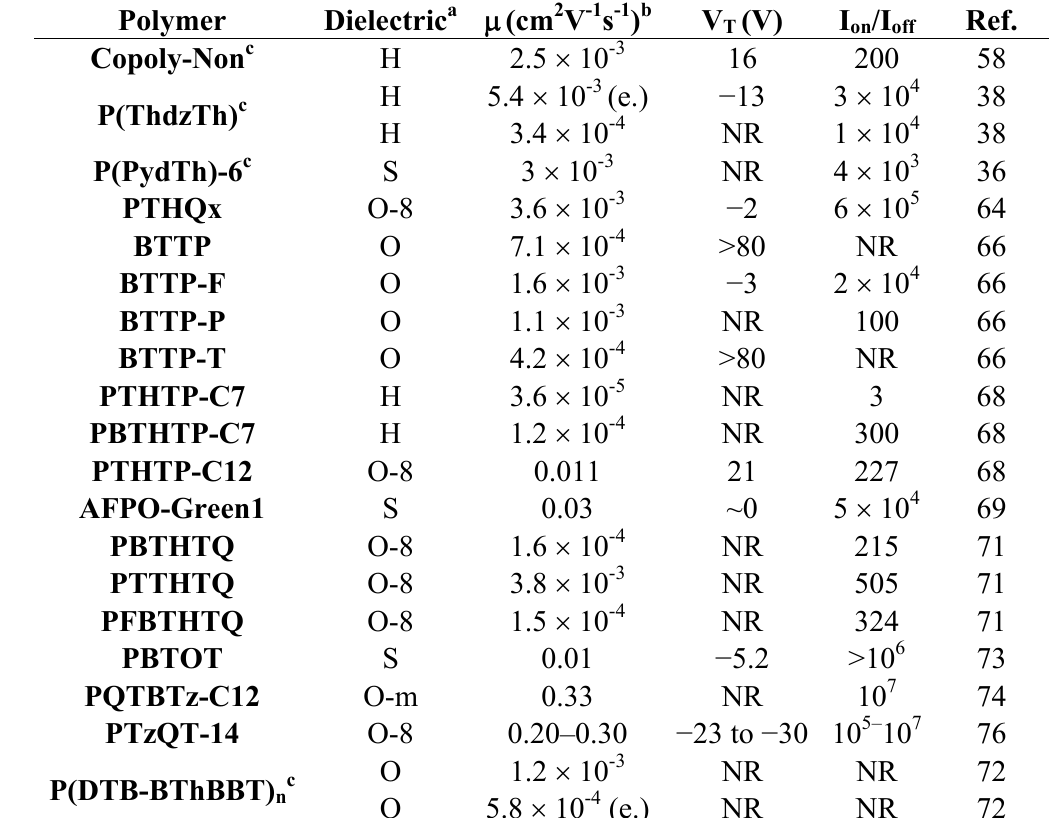
Table 3. Summary of the electrical performance (mobility, μ , current on/off ratio, I and threshold voltage, V ) of the of various azine- and azole-derived semiconducting T copolymers. Hole mobilities and bottom-contact device architectures are utilized unless otherwise